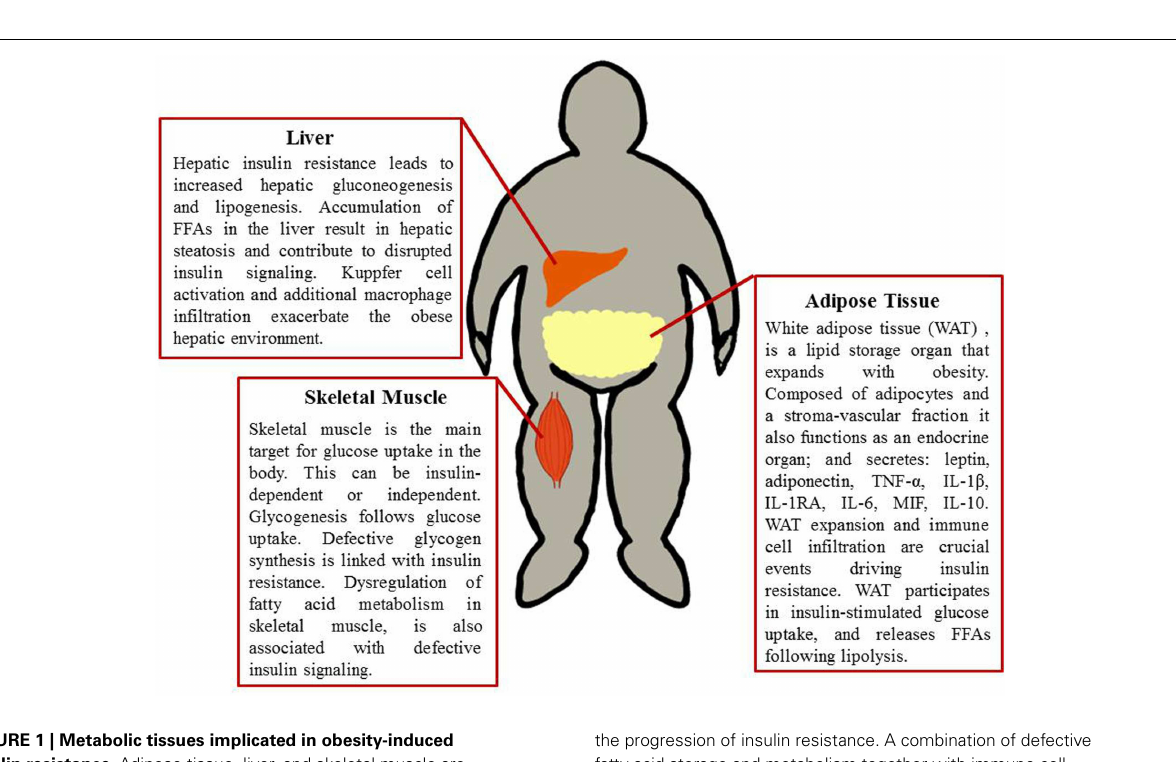
the progression of insulin resistance. A combination of defective fatty acid storage and metabolism together with immune cell infiltration and a pro-inflammatory tissue milieu result in dysregulation of insulin